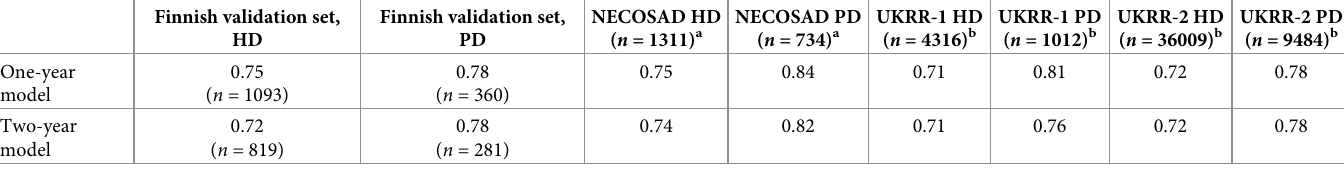
Table 5. Predictive ability of the study models using c-statistic (area under the curve, AUC), stratified by the initial dialysis modality (HD or PD). Results of external validation according to data set. Finnish validation set,